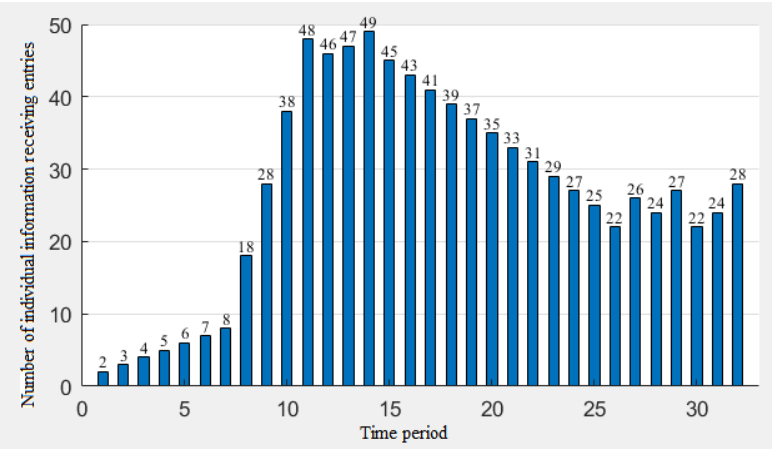
Figure 10. Information reception assignment from 27 December 2019 to 2 May 2020.